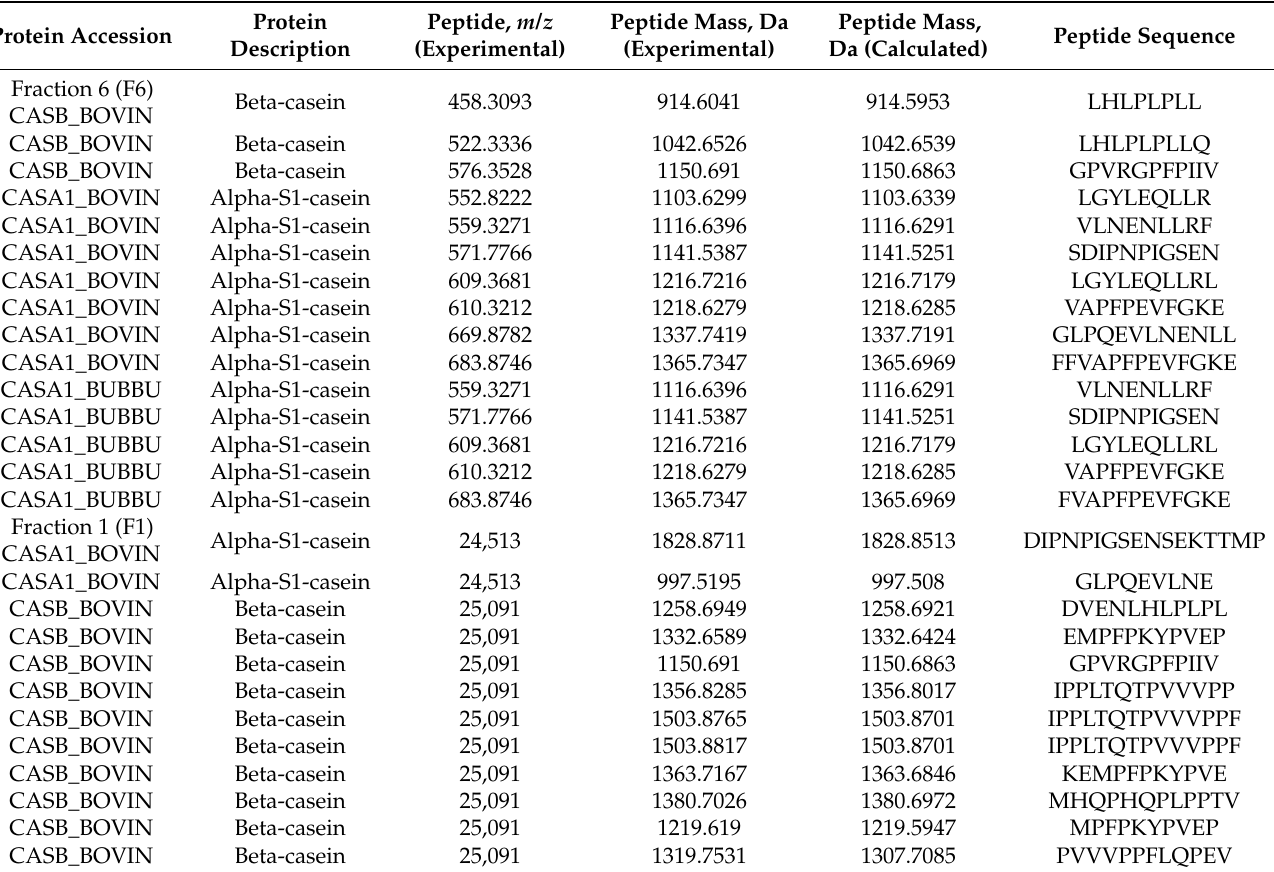
Table 3. Identification of peptides produced from fermented 12% RSM in combination of L. helveticus 8801315 and Flavourzyme ® isolated from RP-HPLC in fractions 6 (F6) and F1 using MALDI-MS/MS analysis. The mascot database search program used was